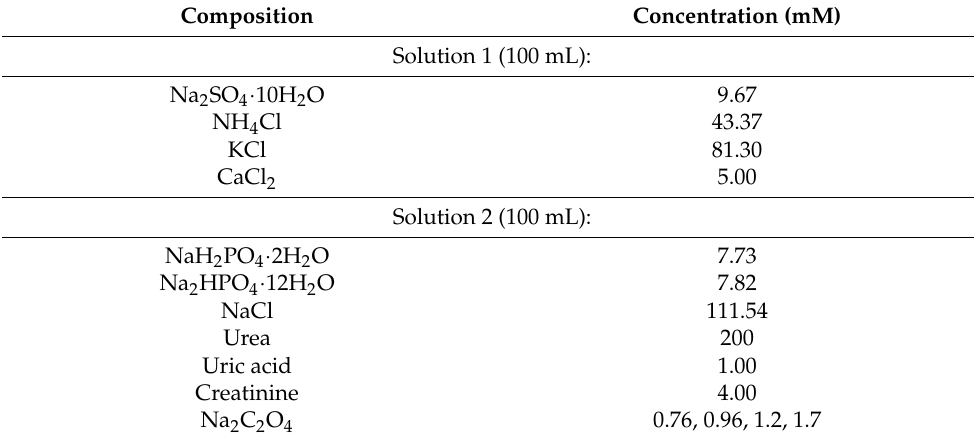
Table 1. The initial concentrations of all the components in solution 1 and solution 2, respectively, before mixing for the synthetic urine adopted in this study.